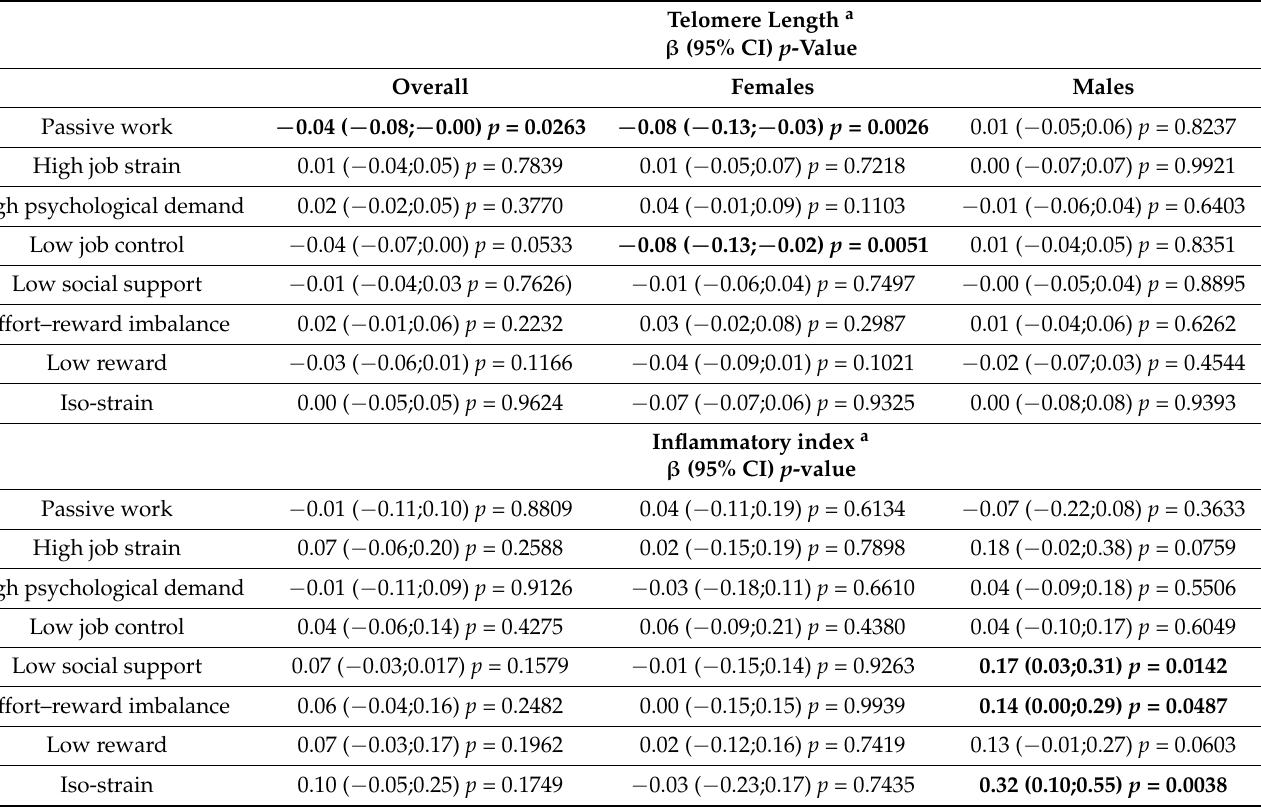
Table 2. Longitudinal associations of work-related psychosocial factors (T2) with telomere length and inflammatory index (T3), overall and by